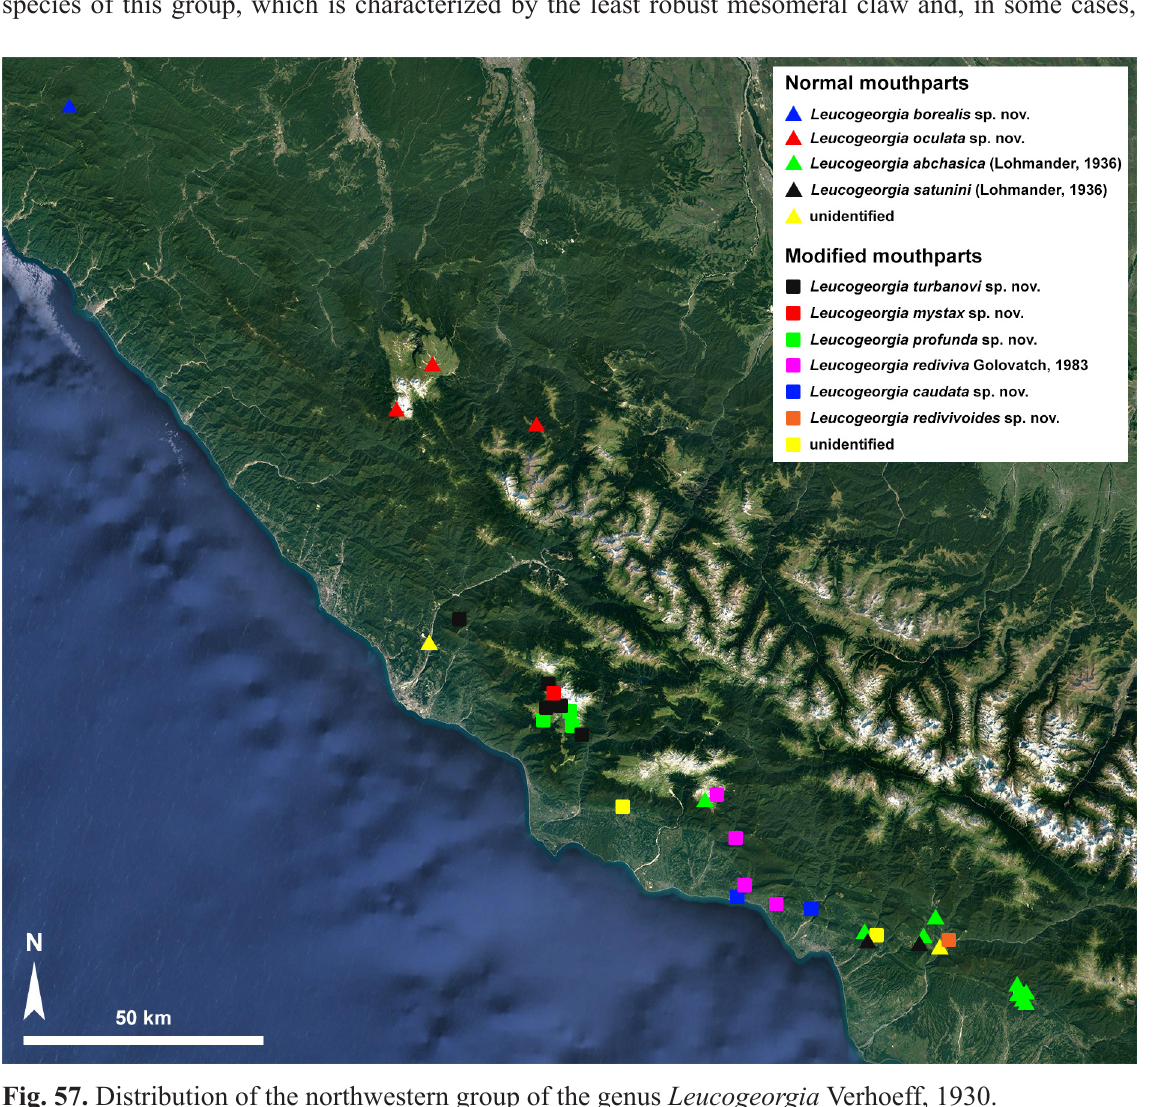
Fig. 57. Distribution of the northwestern group of the genus Leucogeorgia Verhoeff,